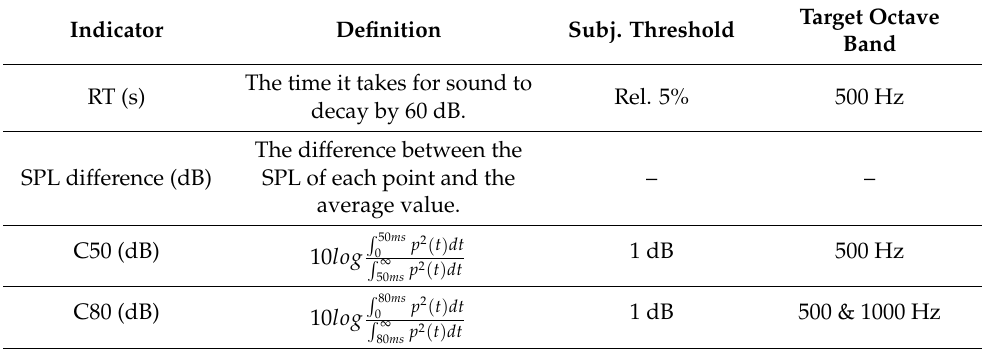
Table 1. Target indoor acoustic indicators.